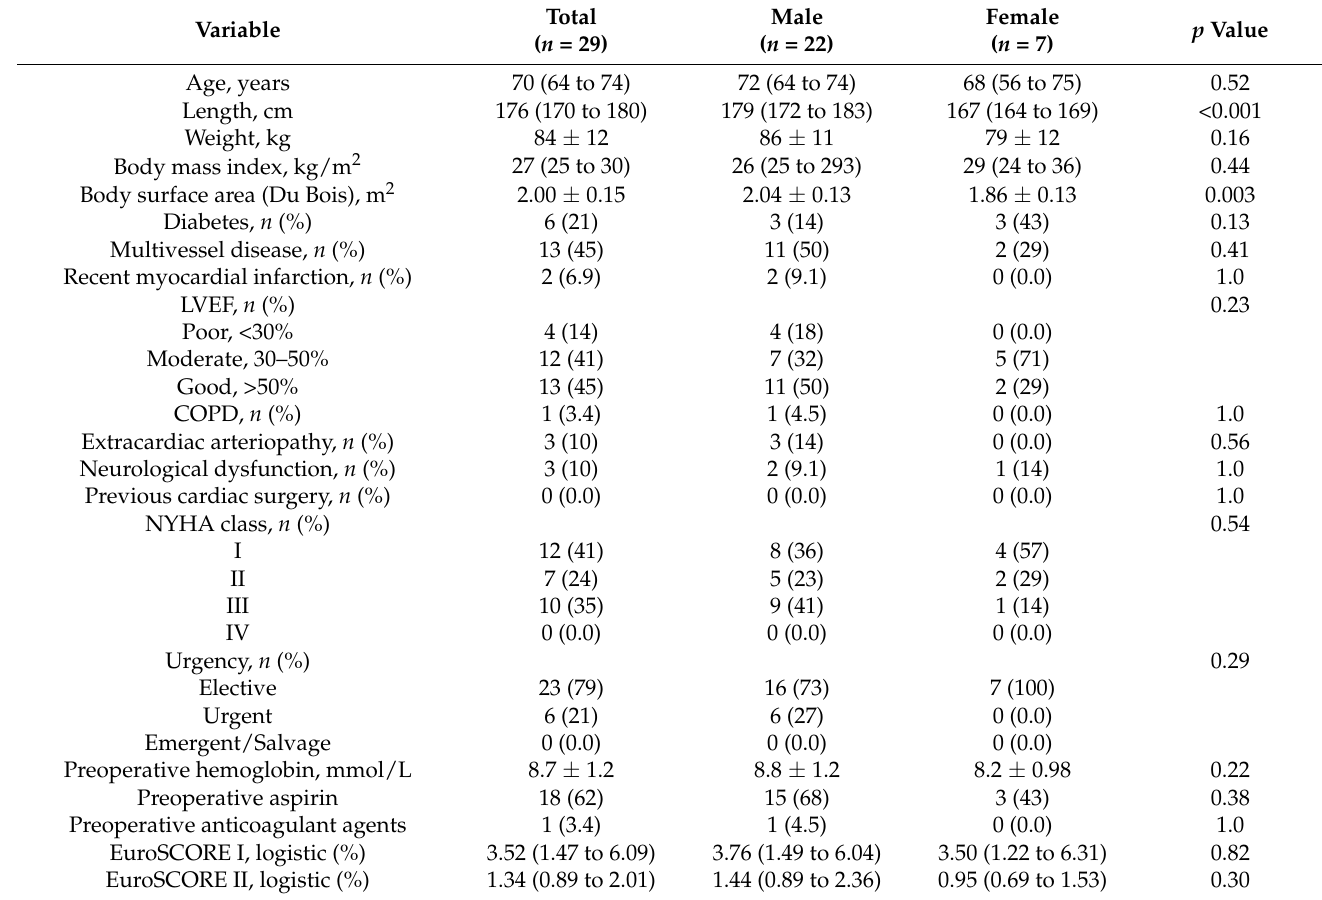
Table 2. Baseline characteristics of the included